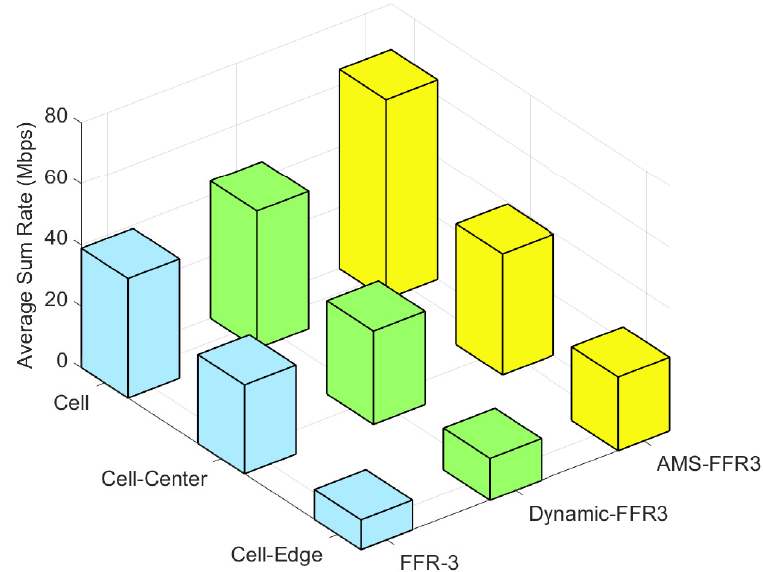
Figure 7. Average sum